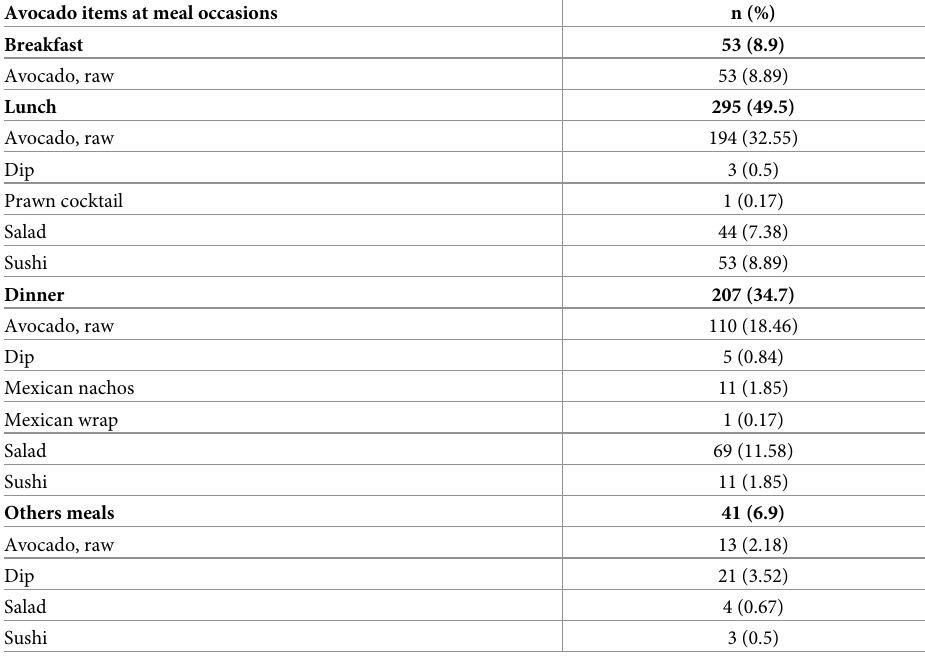
Table 3. Food items containing avocados at meal